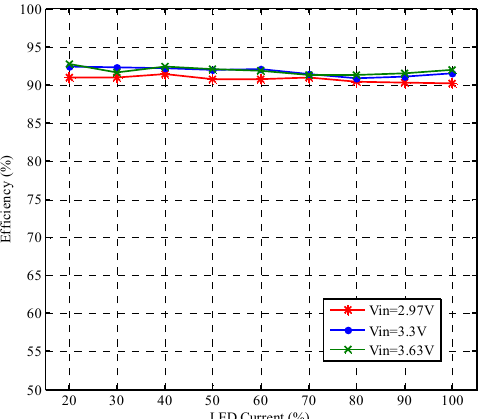
Figure 23. Measured efficiency versus LED current [14].